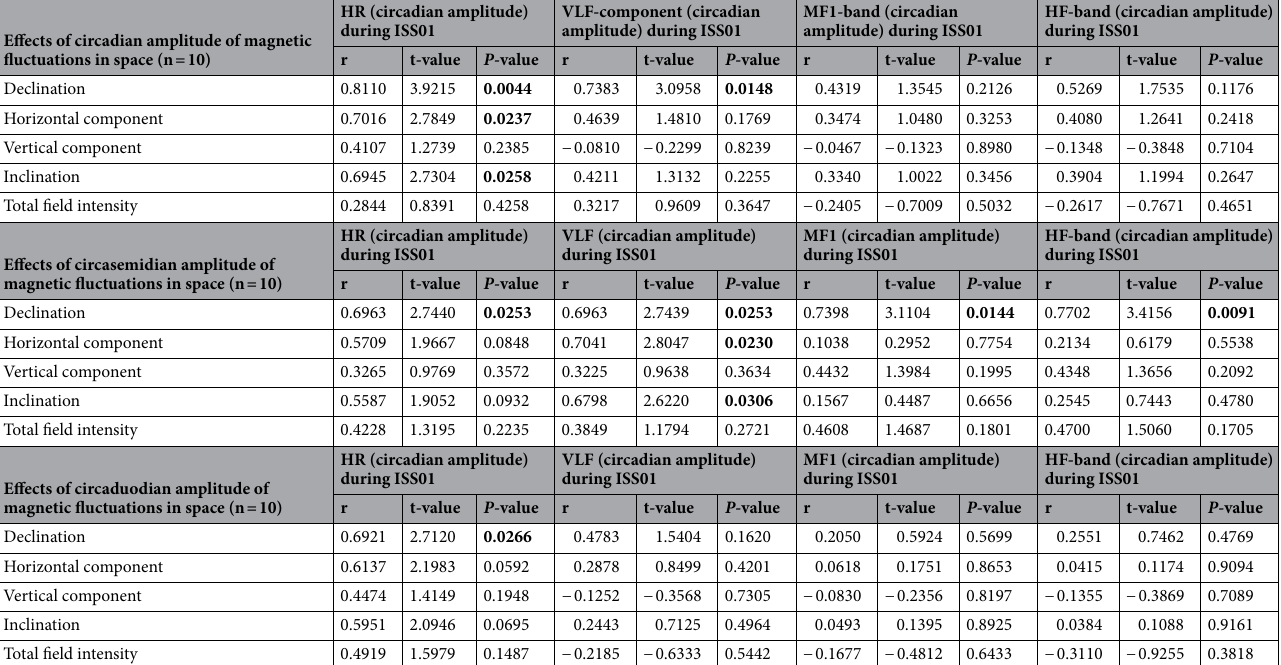
Table 4. Effects of 24-, 12-, and 48-h geomagnetic fluctuations in space on the circadian amplitude of HR and HRV. P- values not corrected for multiple testing. Bold P -values indicates statistically significant correlation of HRV endpoint with geomagnetic